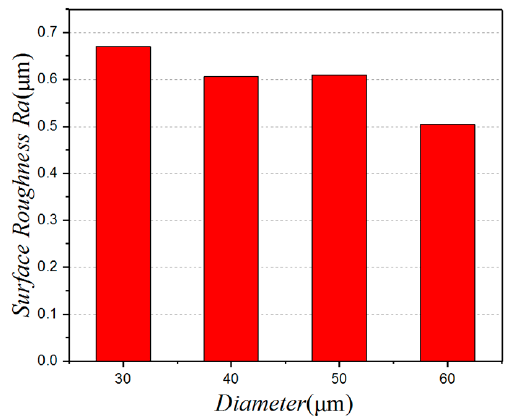
Figure 6. SEM image for a micro ‐ pit with a diameter of 60 μ m. Figure 5. The relationship between the diameter and the surface roughness. Figure 5. The relationship between the diameter and the surface roughness. Figure 5. The relationship between the diameter and the surface roughness.